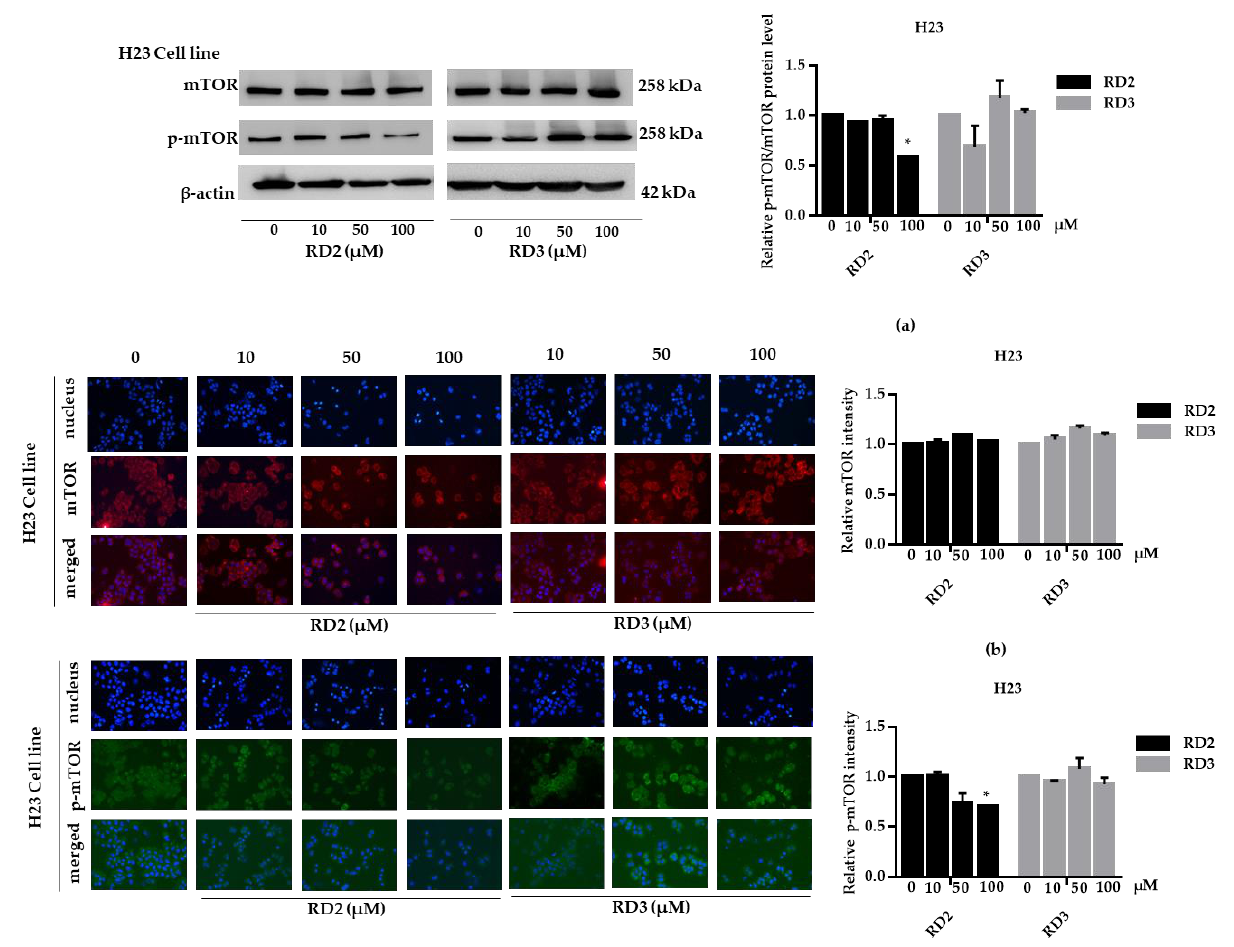
Figure 7. RD2 downregulates p -mTOR in NSCLC cells (H23). The cells were treated with RD2 and RD3 (0–100 µ M) for 24 h. ( a ) Western blot analysis was performed to measure the p -mTOR/mTOR- related proteins. β -Actin protein was evaluated to confirm the equal loading of each protein sample. Densitometry of each protein level was calculated and the results are presented as a relative protein level. ( b ) H23 cells were stained with mTOR (red fluorescence) and Hoechst 33342 (blue fluorescence). The expression of mTOR was determined by immunofluorescence. ( c ) H23 cells were stained with p -mTOR (green fluorescence) and Hoechst 33342 (blue fluorescence). The expression of p -mTOR was examined using immunofluorescence. Relative protein levels were quantified by densitometry. Data are represented as the mean ± SEM. * p < 0.05, when compared with the control group. In the ATP-binding site of Akt-1, the binding affinity for resveratrol and RD2 were − 8.054 and − 8.041 kcal/mol, respectively (Table 1). The binding modes of all ligands